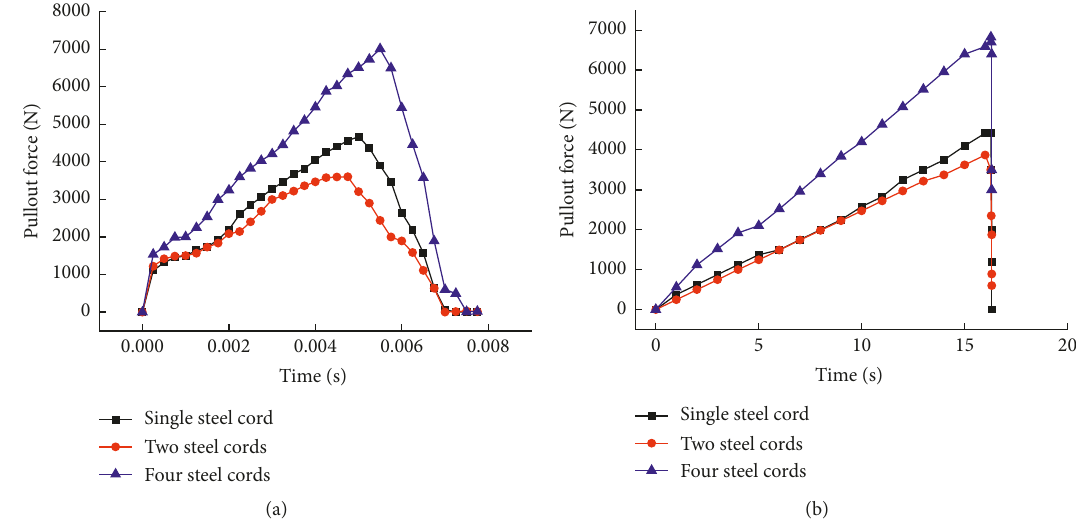
Figure 13: The change in pullout force with different steel cord numbers. (a) Numerical results. (b) Experimental